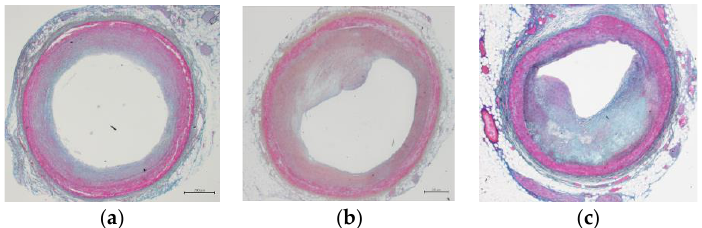
Figure 1. Microscopic image of coronary lumen narrowing caused by atherosclerosis after Azan